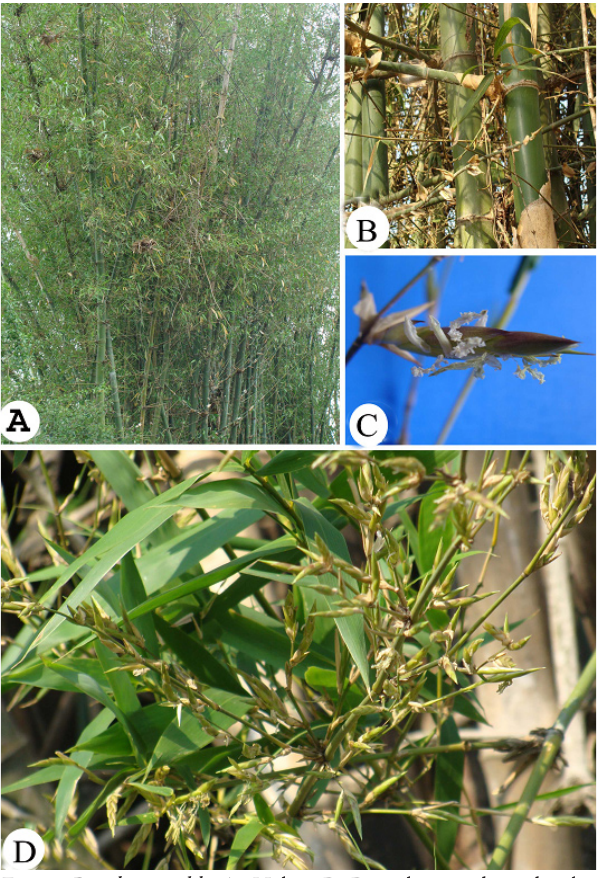
Fig. 1. Bambusa tulda A. Habit; B. Branches, node and culm sheath; C. Flowers;D. Inflorescence